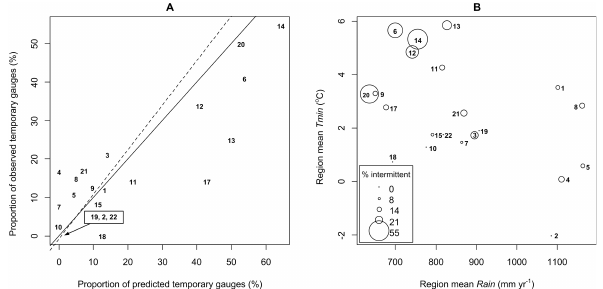
Fig. 10. (A) Observed and predicted proportions of gauging stations on intermittent segments in hydro-ecoregions. The dashed line is the regression of observed versus predicted gauges on intermittent segments. The solid line indicates a perfect agreement between ob- served and predicted (i.e., slope=1 and intercept=0). (B) Scatter plot of the mean values of the most important predictor variables (Tmin and Rain) in each HER. The symbol sizes indicate the per- centage of gauges on intermittent segments each